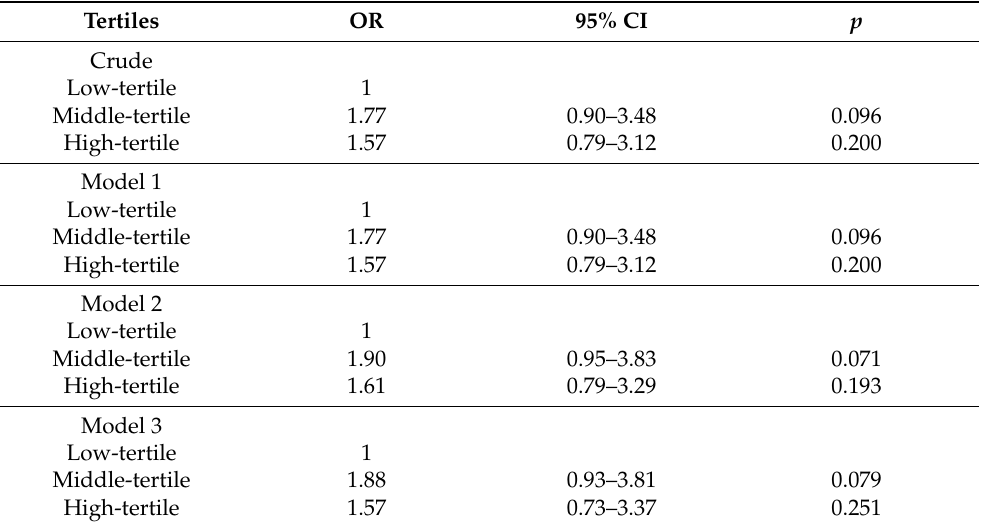
Table 4. Multivariate logistic regression on the relationship between the sua tertiles and rapid decline in